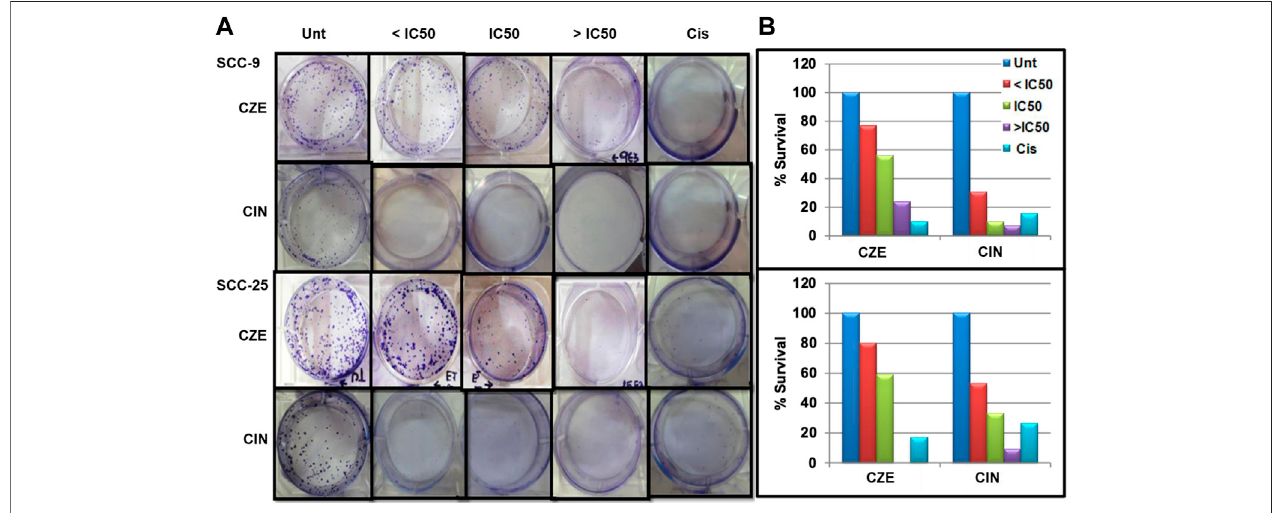
FIGURE 3 | Clonogenic assay (A) Representative images of colony forming assay after treatment with CZE and CIN on SCC-9 and SCC-25 cells at 48 h (B) Bar graph showing % CFU of cancer cells after treatment with CZE and CIN. Cinnamomum zeylanicum extract (CZE), cinnamaldehyde (CIN) and Cisplatin (Cis).